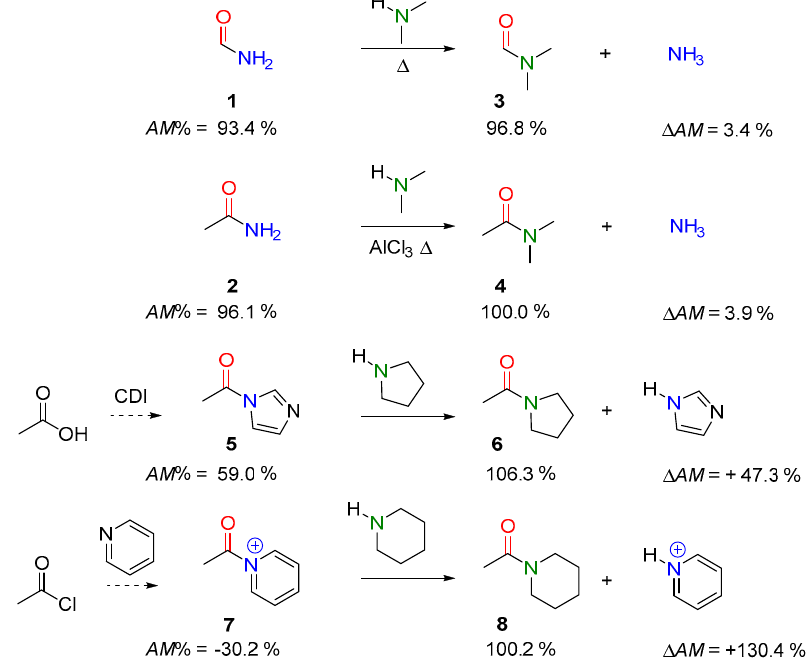
Figure 6. Examples for transamidation involving secondary amine, with the corresponding amidicity values computed at B3LYP/6-31G(d,p) level of theory.